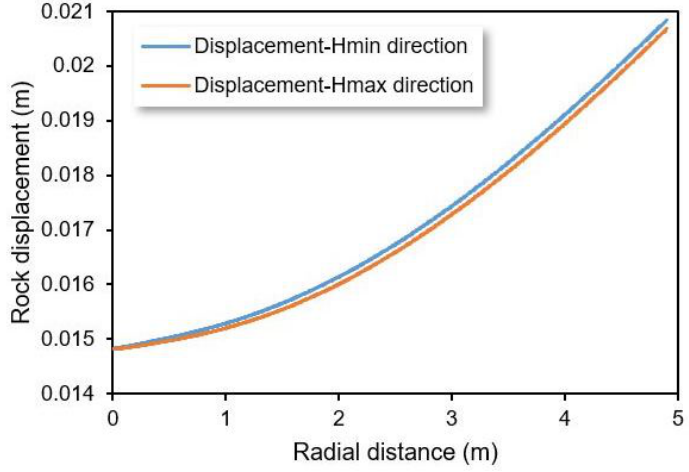
Figure 19. CSMP++ graphical plot of the rock displacement in the minimum and maximum